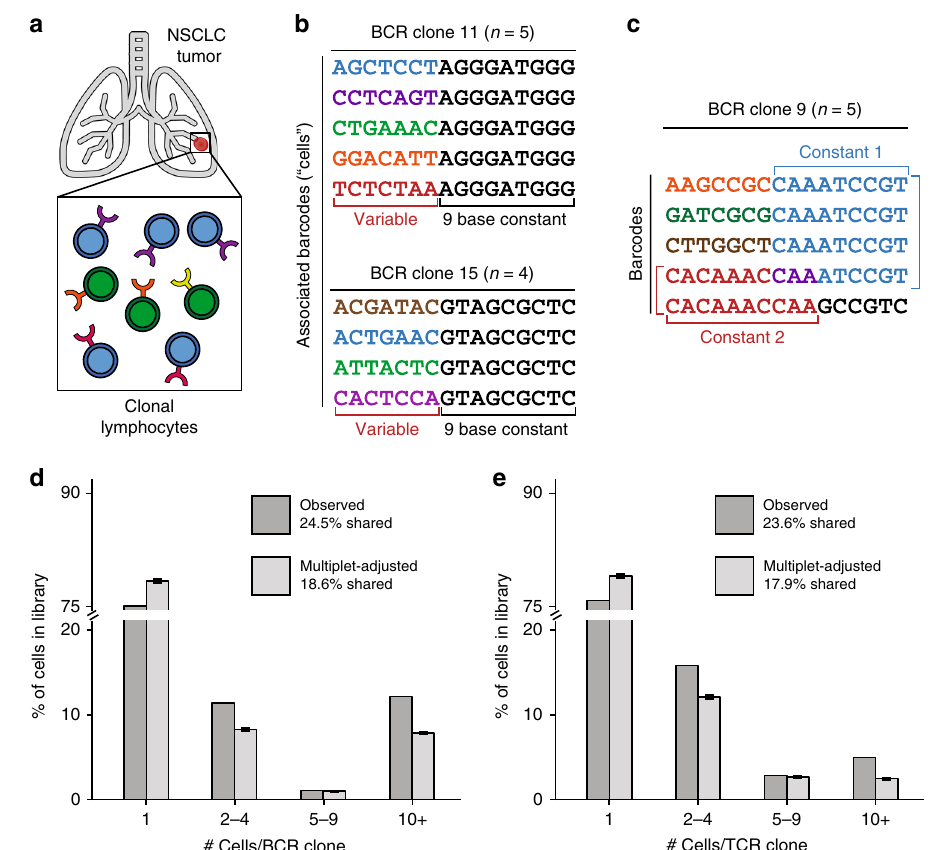
Fig. 4 Confounding of intratumor clonal lymphocytes inference from barcode multiplets. a Schematic of intra-tumor lymphocytes identi fi ed from single- cell V(D)J sequencing on the 10× platform. b Identi fi cation of two presumed clonotypes composed of fi ve and four barcodes. These clonotypes are likely to have been derived from one cell observed multiple times via barcode multiplets. c Example of a presumed clone composed of fi ve barcodes with multiple constant sequences. d , e Overall summary of prevalence of d B-cell and e T-cell clone size before and after adjusting for observed rates of barcode multiplets in single-cell data. Error bars represent standard errors of the mean across n = 100 independent permutations from one experimental dataset per receptor sequence. Source data are available in the Source Data fi